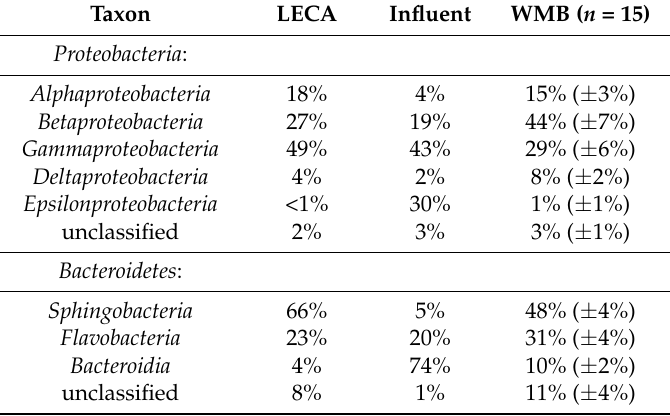
Table A4. Proportions of classes of two dominant phyla, Proteobacteria and Bacteroidetes , in wetland media biofilm (WMB), influent and LECA. Standard deviations are given in